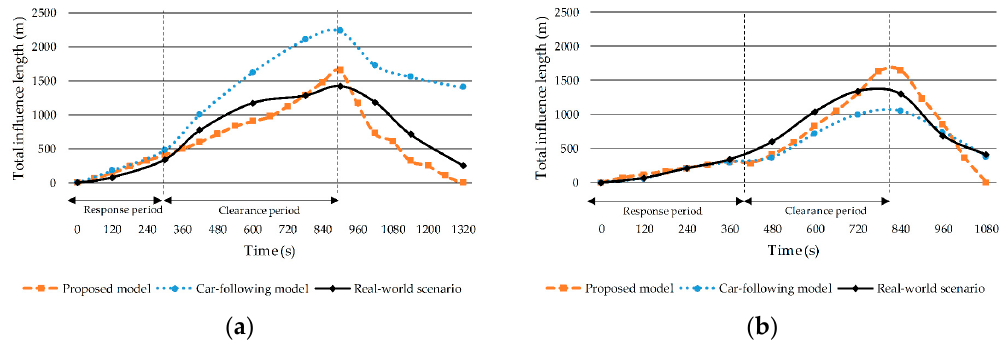
Figure 8. Total influence length comparison between the proposed model, car-following model, and real-world scenario of ( a ) Case A; and ( b ) Case B.